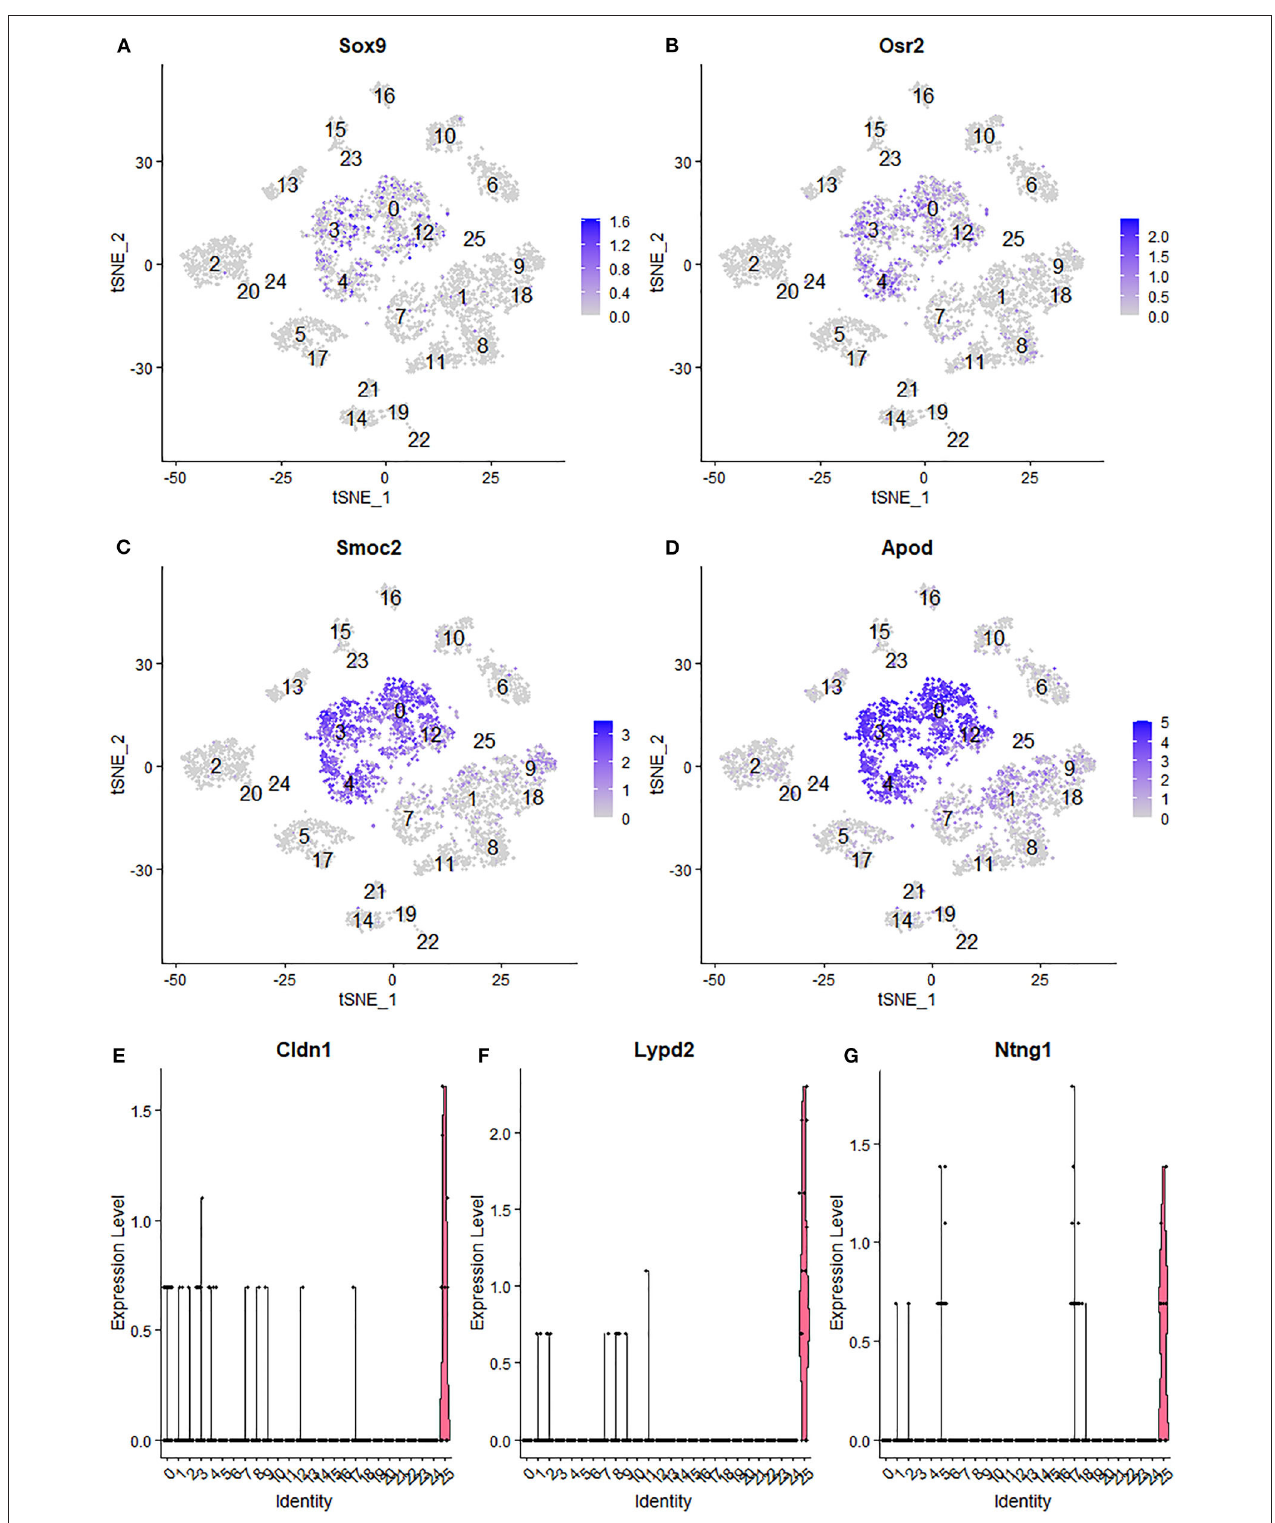
FIGURE 7 | Identifying endoneurial fibroblasts and perineurial cells in data set GSE142541. (A,B) tSNE plot showing Sox9 and Osr2 expression in endoneurial fibroblasts (cluster 0, 3, 4, and 12). (C,D) tSNE plot showing Smoc2 and Apod expression in endoneurial fibroblasts. (E,F) Violinplot showing Cldn1, Lypd2, and Ntng1 expression in perineurial cells (cluster